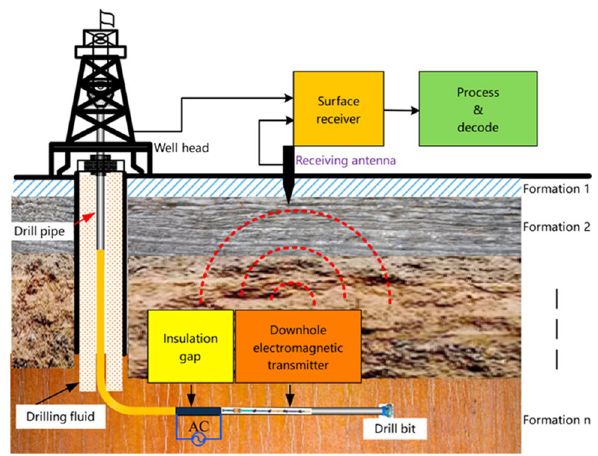
Fig. 19 Schematic of electromagnetic telemetry, after Liu